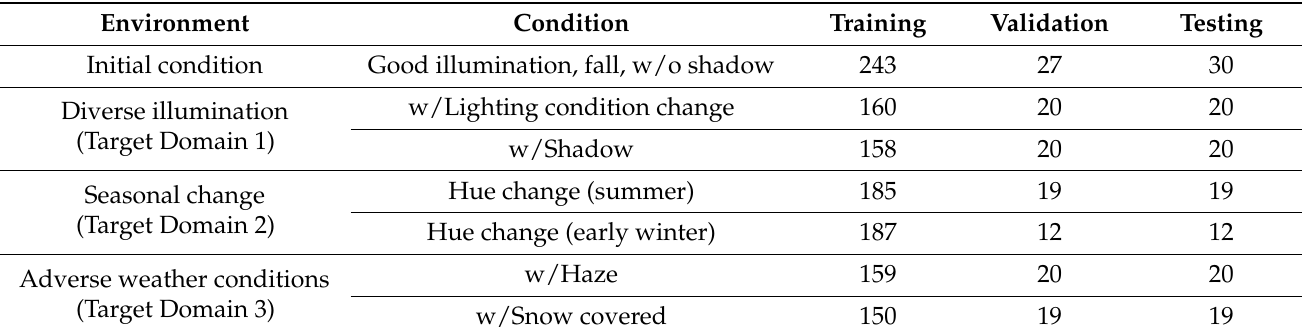
Table 2. Experimental data collection distributed under different environmental conditions (note: there are images cross counted in different conditions).